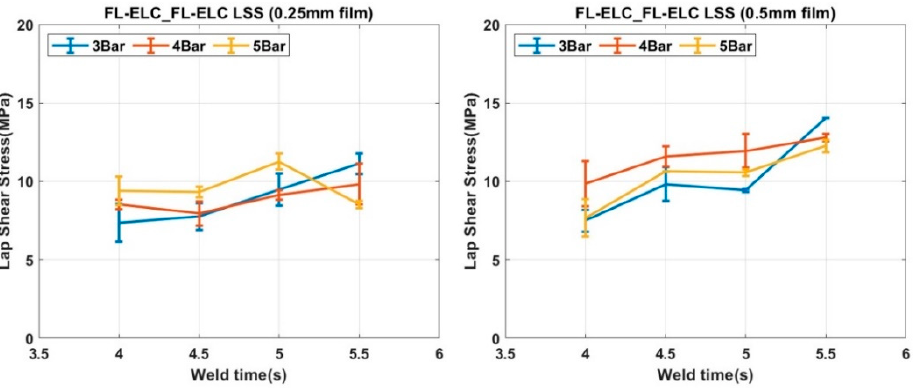
Figure 19. LSS values of FL-ELC_FL-ELC (0.25 mm and 0.5 mm ED film).